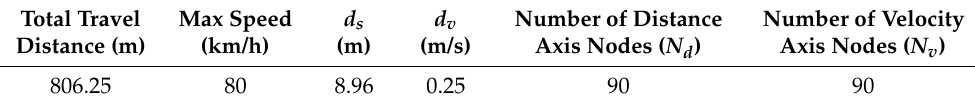
Table 2. Discretization and parameters for dynamic programming.